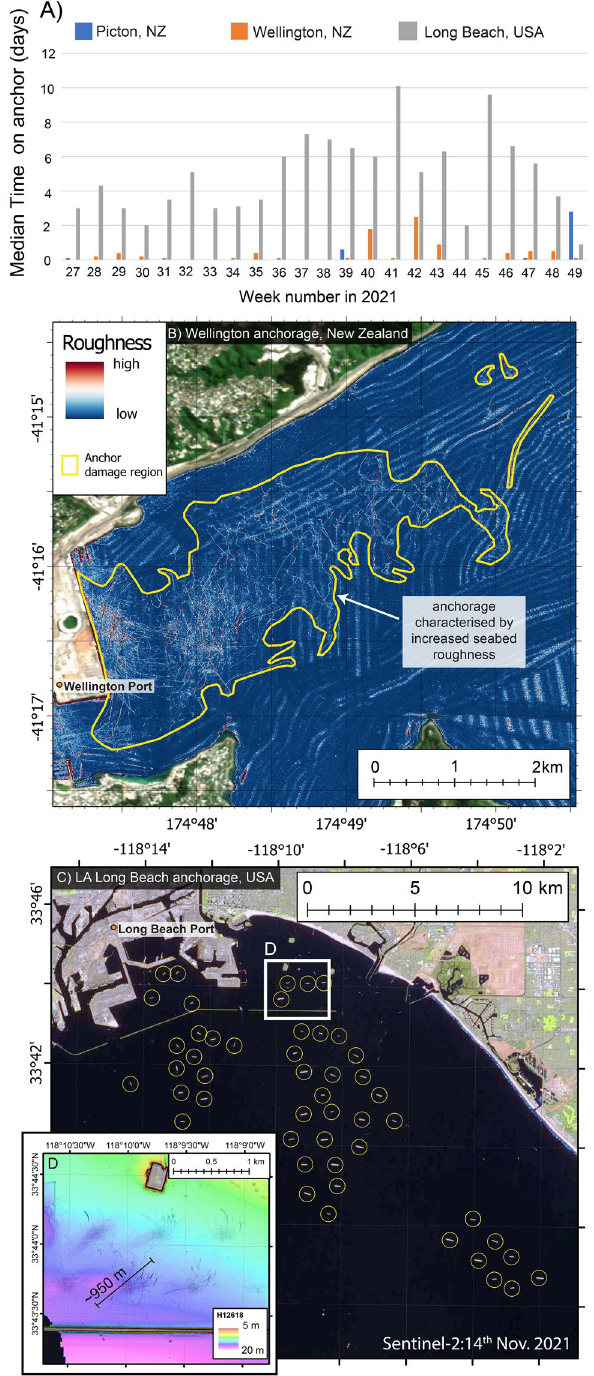
Figure 4. ( A ) Documented anchorage use for 23 weeks in 2021 at Picton anchorage, NZ, compared to Wellington anchorage, NZ, and Long Beach anchorage, USA. Data obtained from Marine Traffic (https:// www. marin etraffi c. com). The median anchorage use per week in Picton is substantially lower than all other ports presented and likely represents a low-congestion anchorage area globally. ( B ) Seafloor data from Wellington anchorage region (collected in 2007–2008 44 ) showing region characterised by increased seafloor roughness in the anchoring region (yellow polygon). Background satellite image obtained from Land Information New Zealand LINZ, 10 m (2018–2019). ( C ) Sentinel-2 Satellite imagery data (obtained from https:// earth explo rer. usgs. gov/ Entity ID: L1C_T11SLT_A024506_20211114T184314, Tile number: T11SLT) showing at least 49 ships on anchor outside the LA Long Beach port on the 14th November 2021. This likely represents the spatial expansion of the anchorage region as a result of unrelenting port congestion since the beginning of the COVID- 19 pandemic and an example of the potential future of port congestion. ( D ) Bathymetry data (collected in 2013 45 ) from Long Beach anchorage showing anchor footprint analogous to that observed at